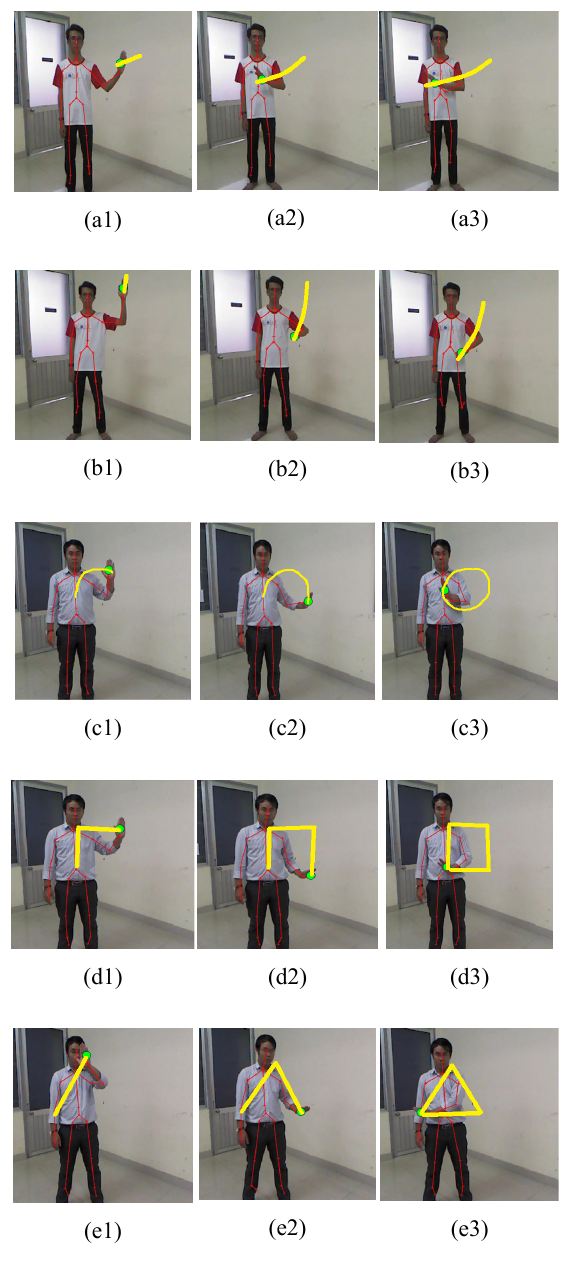
Figure 10 . The process of recording